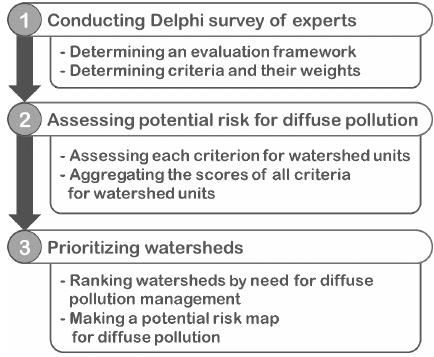
Figure 1. Study procedure.